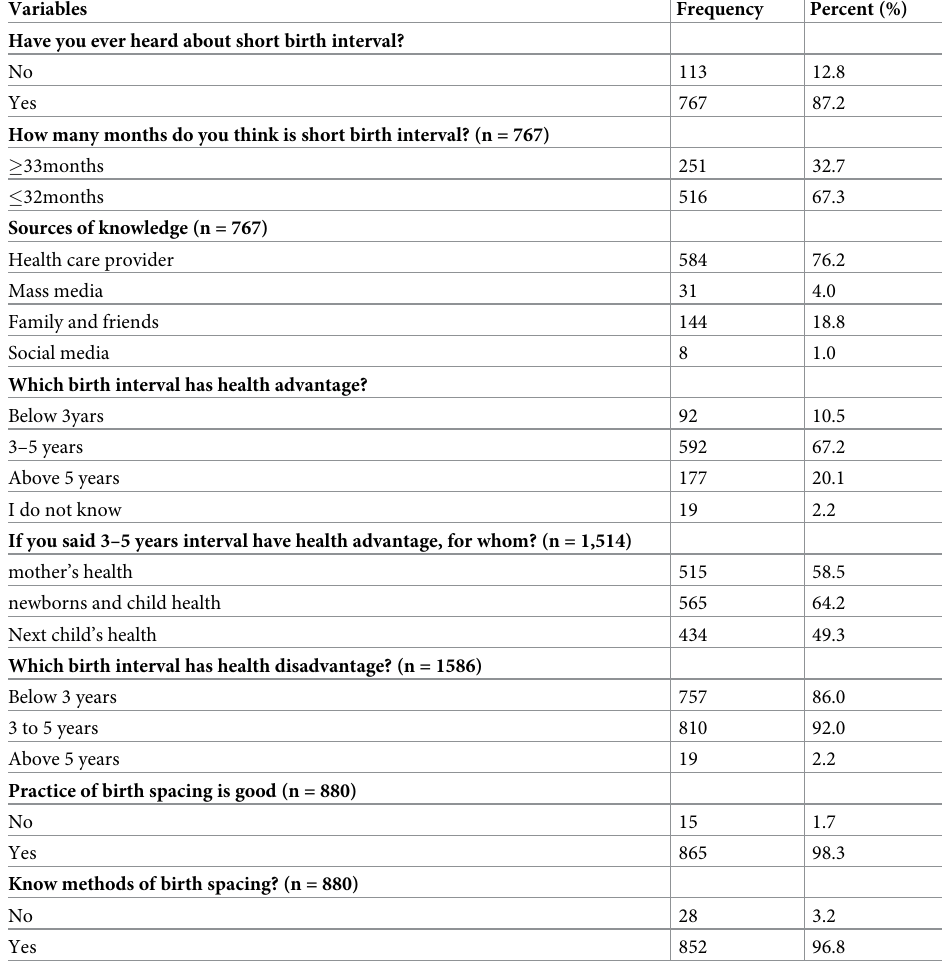
Table 3. Knowledge of study participants about short birth interval in Dembecha, northwest Ethiopia, 2019. Variables Frequency Percent